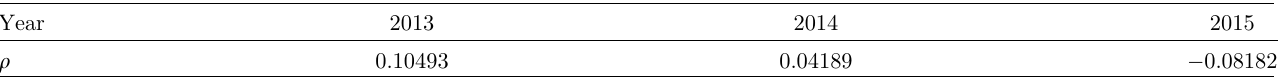
Table 1. Spearman ’ s correlation coef fi cient q between the ranks of the proportion of students classi fi ed under the basic level and ranks of the proportion of